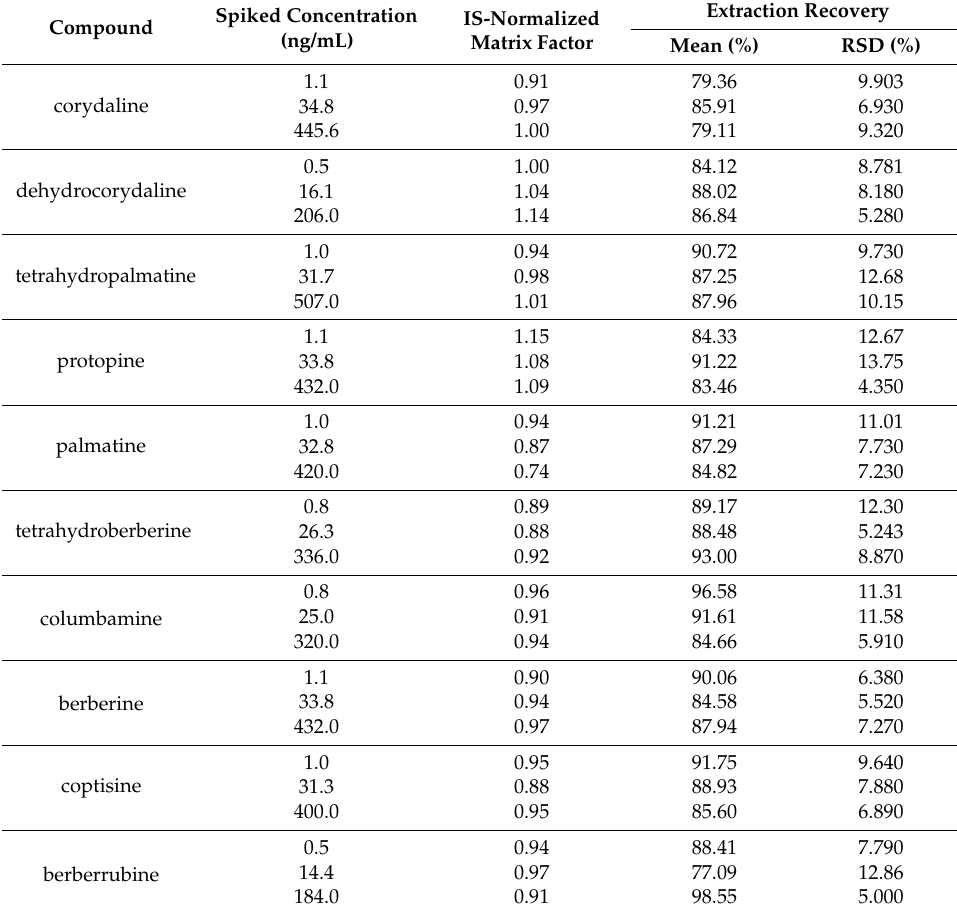
Table 3. IS-normalized matrix factor and extraction recovery for the 10 alkaloids in the beagle dog plasma. ( n =